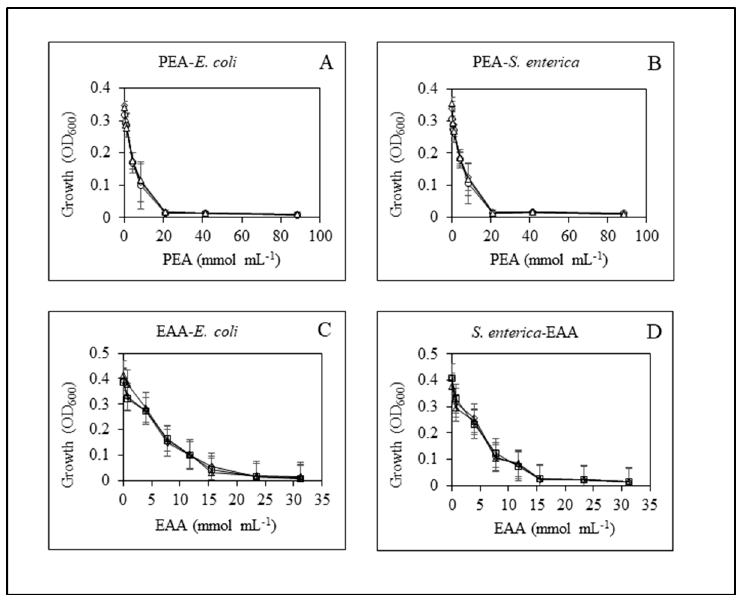
Figure 3. Anti-microbial activities of unheated, 73.9 °C heated, and 93.3 °C heated PEA-HCl (Panel ( A , B )) and EAA (Panel ( C , D )). E. coli and S. enterica were used as reference strains. Squares, unheated samples; diamonds, 73.9 °C samples; triangles, 93.3 °C samples. MBCs were determined from live bacterial counts at concentrations in the vicinity of the respective MIC. For unheated, 73.9 °C heated, and 93.3 °C heated PEA-HCl, the MBC